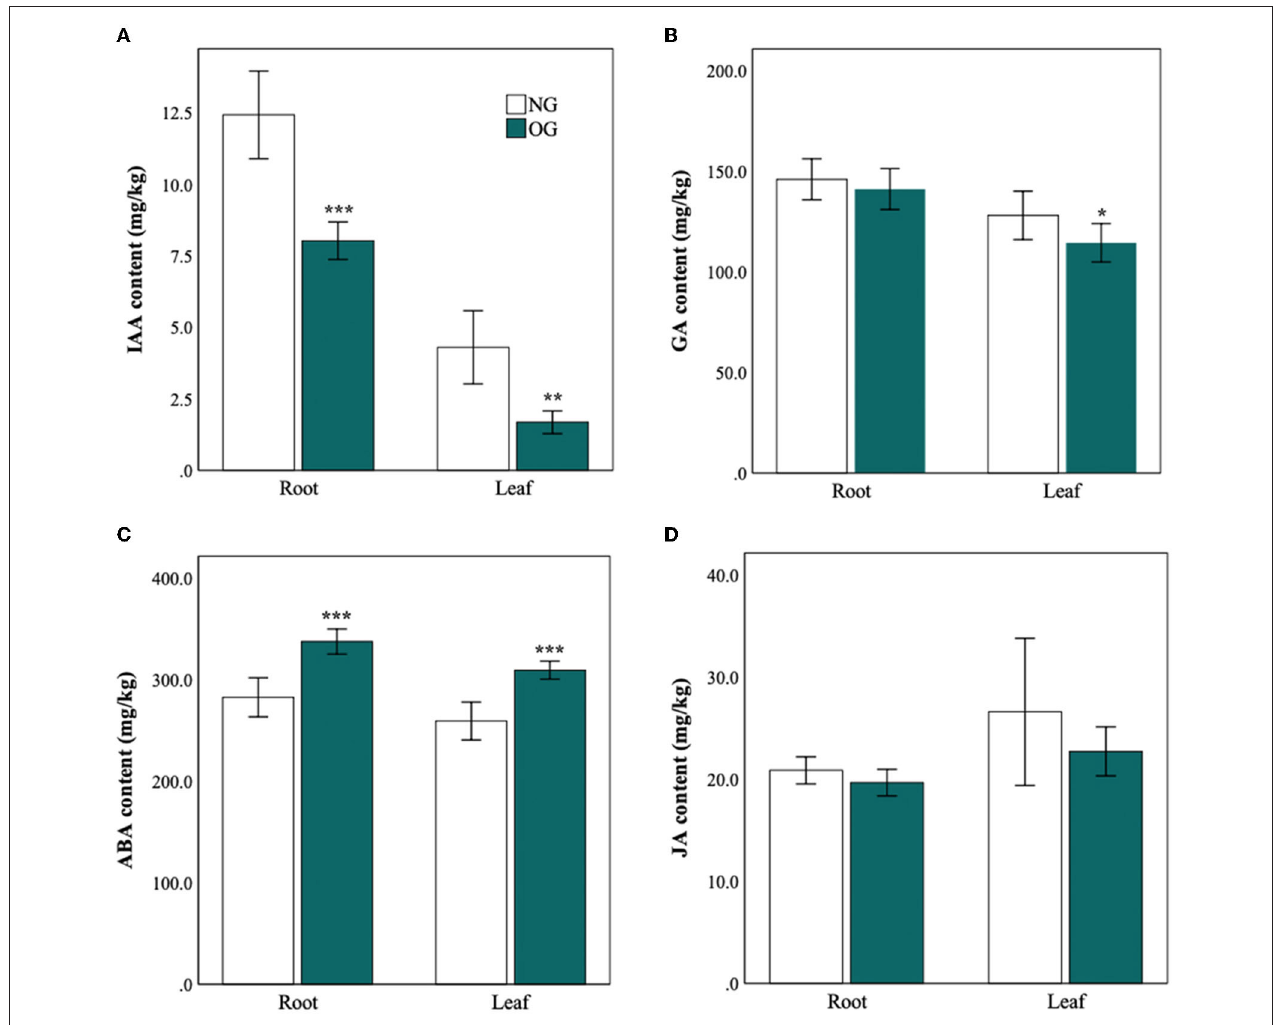
FIGURE 2 | Different hormone levels in roots and leaves of L. chinensis in response to NG and OG. (A) Auxin (IAA) concentration; (B) gibberellic acid (GA) concentration; (C) abscisic acid (ABA) concentration; and (D) jasmonic acid (JA) concentration. Statistical significance is denoted by *** P < 0.001; ** P < 0.01; * P < 0.05. Error bars denote standard error of the